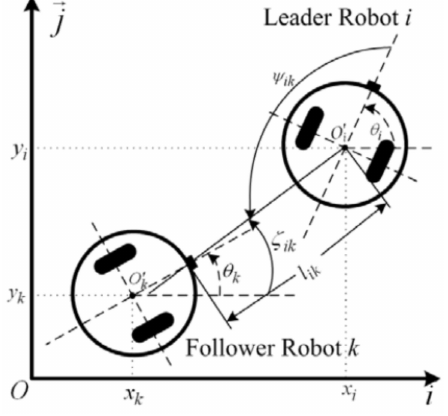
Figure 2. Sketches of a leader-follower